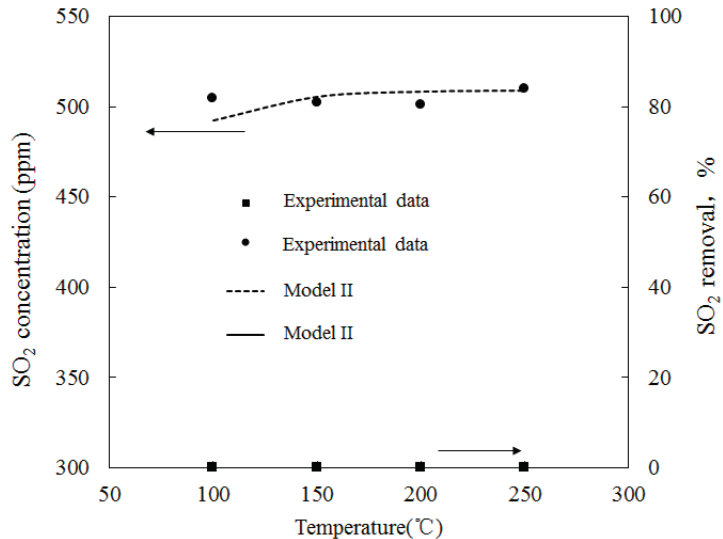
Figure 12. Variations of SO 2 concentration with temperatures where the mole ratio of O 3 /SO 2 equals.